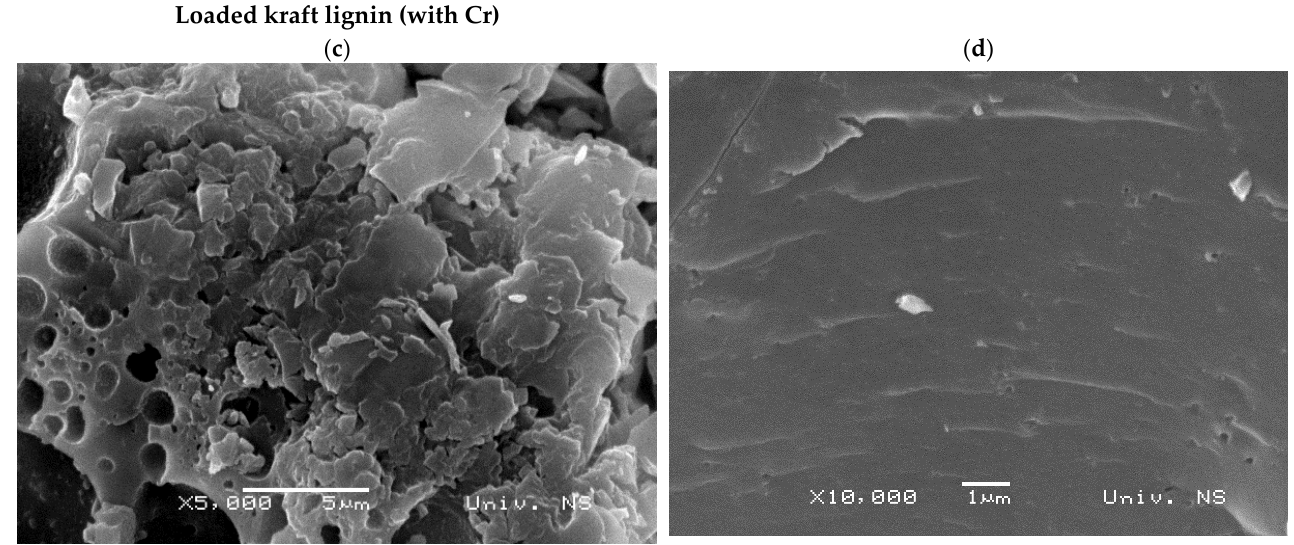
Figure 10. SEM images of the eucalypt stump and kraft lignin after adsorption of Cr(VI) ions. Mag- nification scales: ( a , c )—×5000; ( b , d )—×10,000.